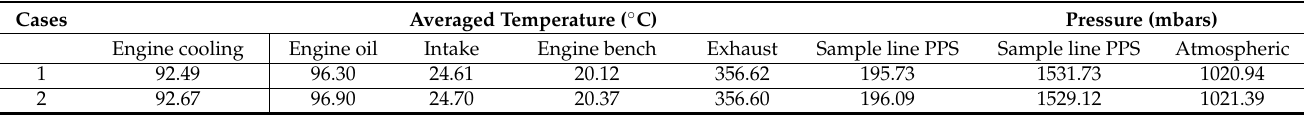
Table 2. Test conditions.